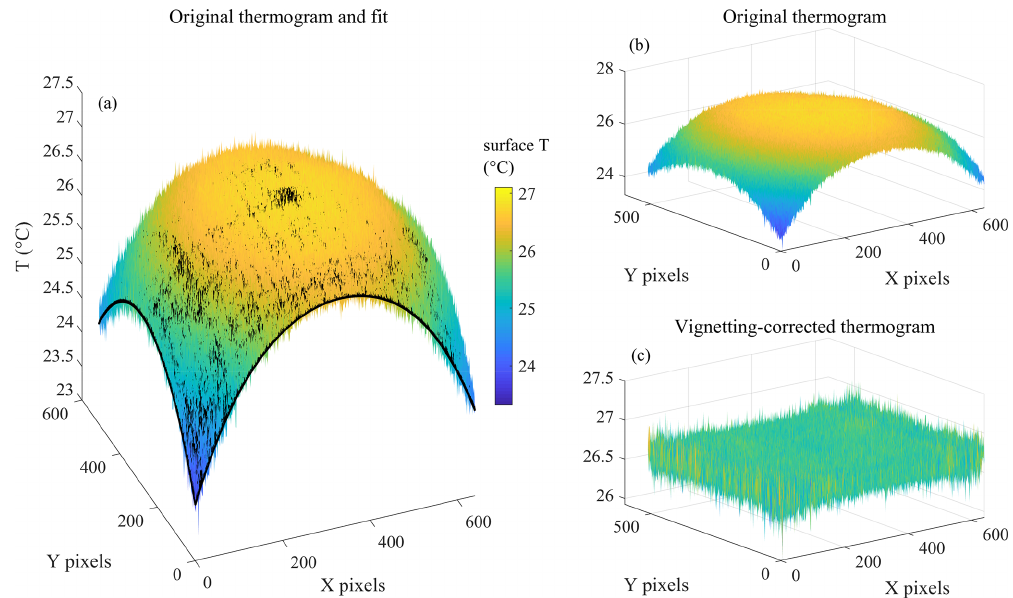
Figure A1. (a) Fourth-order polynomial fit (black surface) and the thermogram of the black fabric (RMSE = 0.08K); (b) uncorrected ther- mogram of black fabric surface (same data as in a ); (c) vignetting-corrected thermogram.